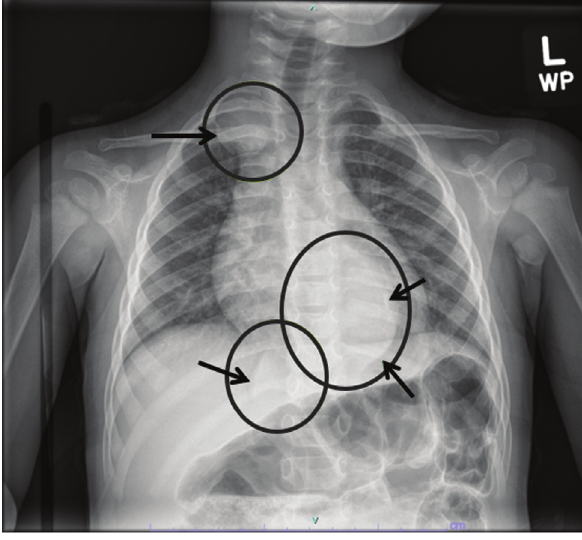
Fig. 3 A dedicated chest X-ray showing three masses annotated with circles and